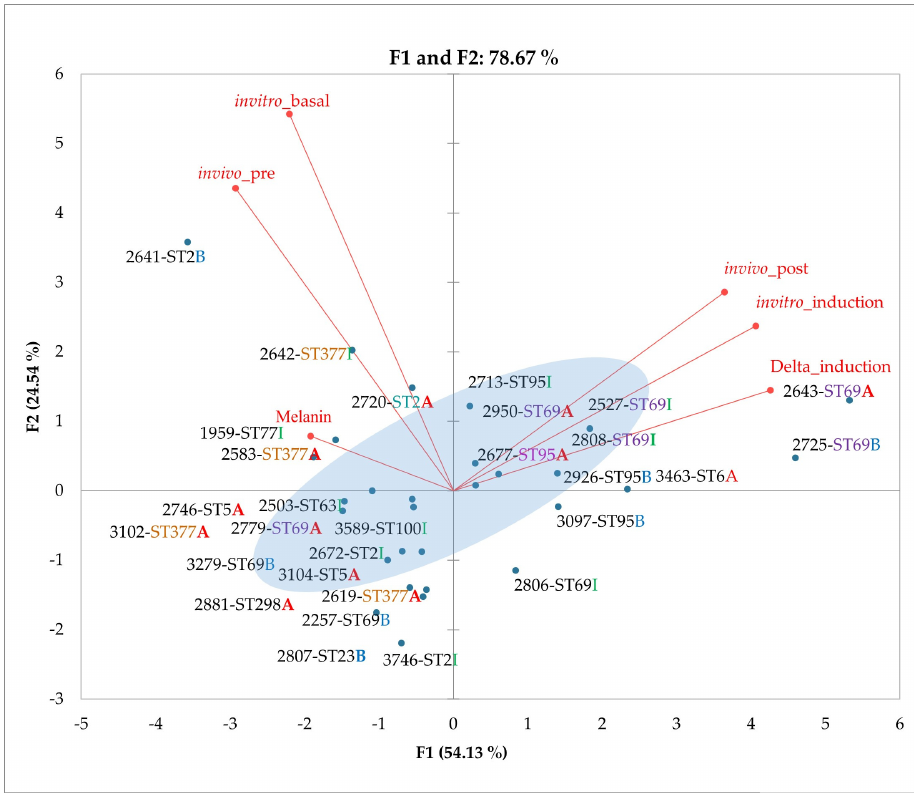
Figure 6. Coordinates calculated via principal component analysis for each isolate and membership of isolates in the proposed categories. A positive correlation is observed; the variable that has the most weight in the analysis is the difference in capsular induction, followed by the variables corresponding to both the in vitro induction in capsular induction medium and the in vivo model. B, I and A correspond to low, intermediate and high pathogenicity, respectively. The modulation of the capsule size can be seen in the blue halo. Filled circles are colored red for active variables and blue for active observations.